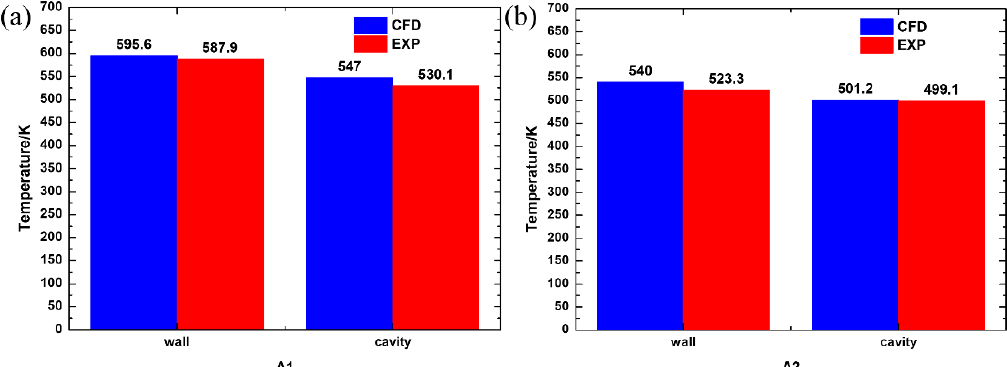
Figure 4. Comparison of the average temperature of the cavity and the casing wall obtained from the experiment and the simulation in Scheme 1: ( a ) section A1; ( b ) section A2.